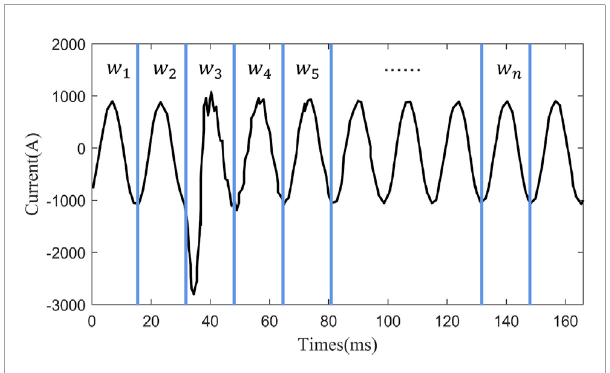
FIGURE 2 An illustration of WSRF: the current of a faulted phase in a cable incipient fault is split into several